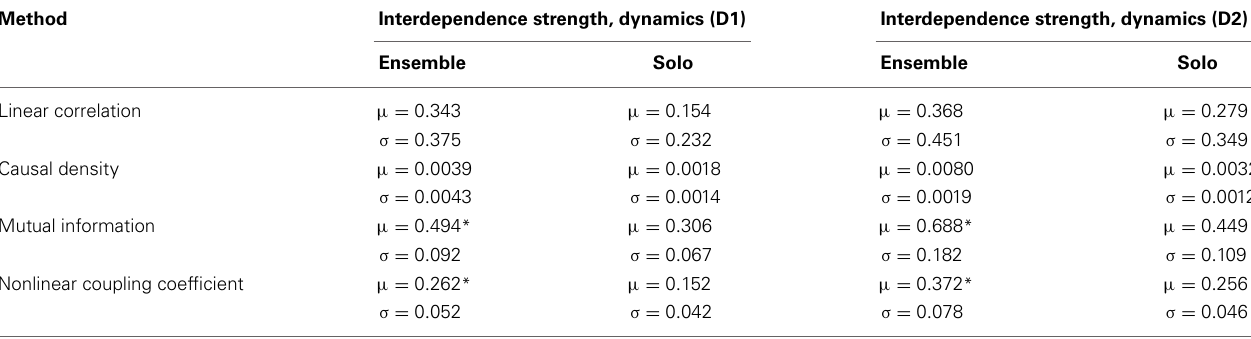
Table 3 | Mean ( μ ) and standard deviation ( σ , N = 7 for exercise D1 and N = 6 for exercise D2) of interdependence strength for the Dynamics dimension, per exercise and experimental